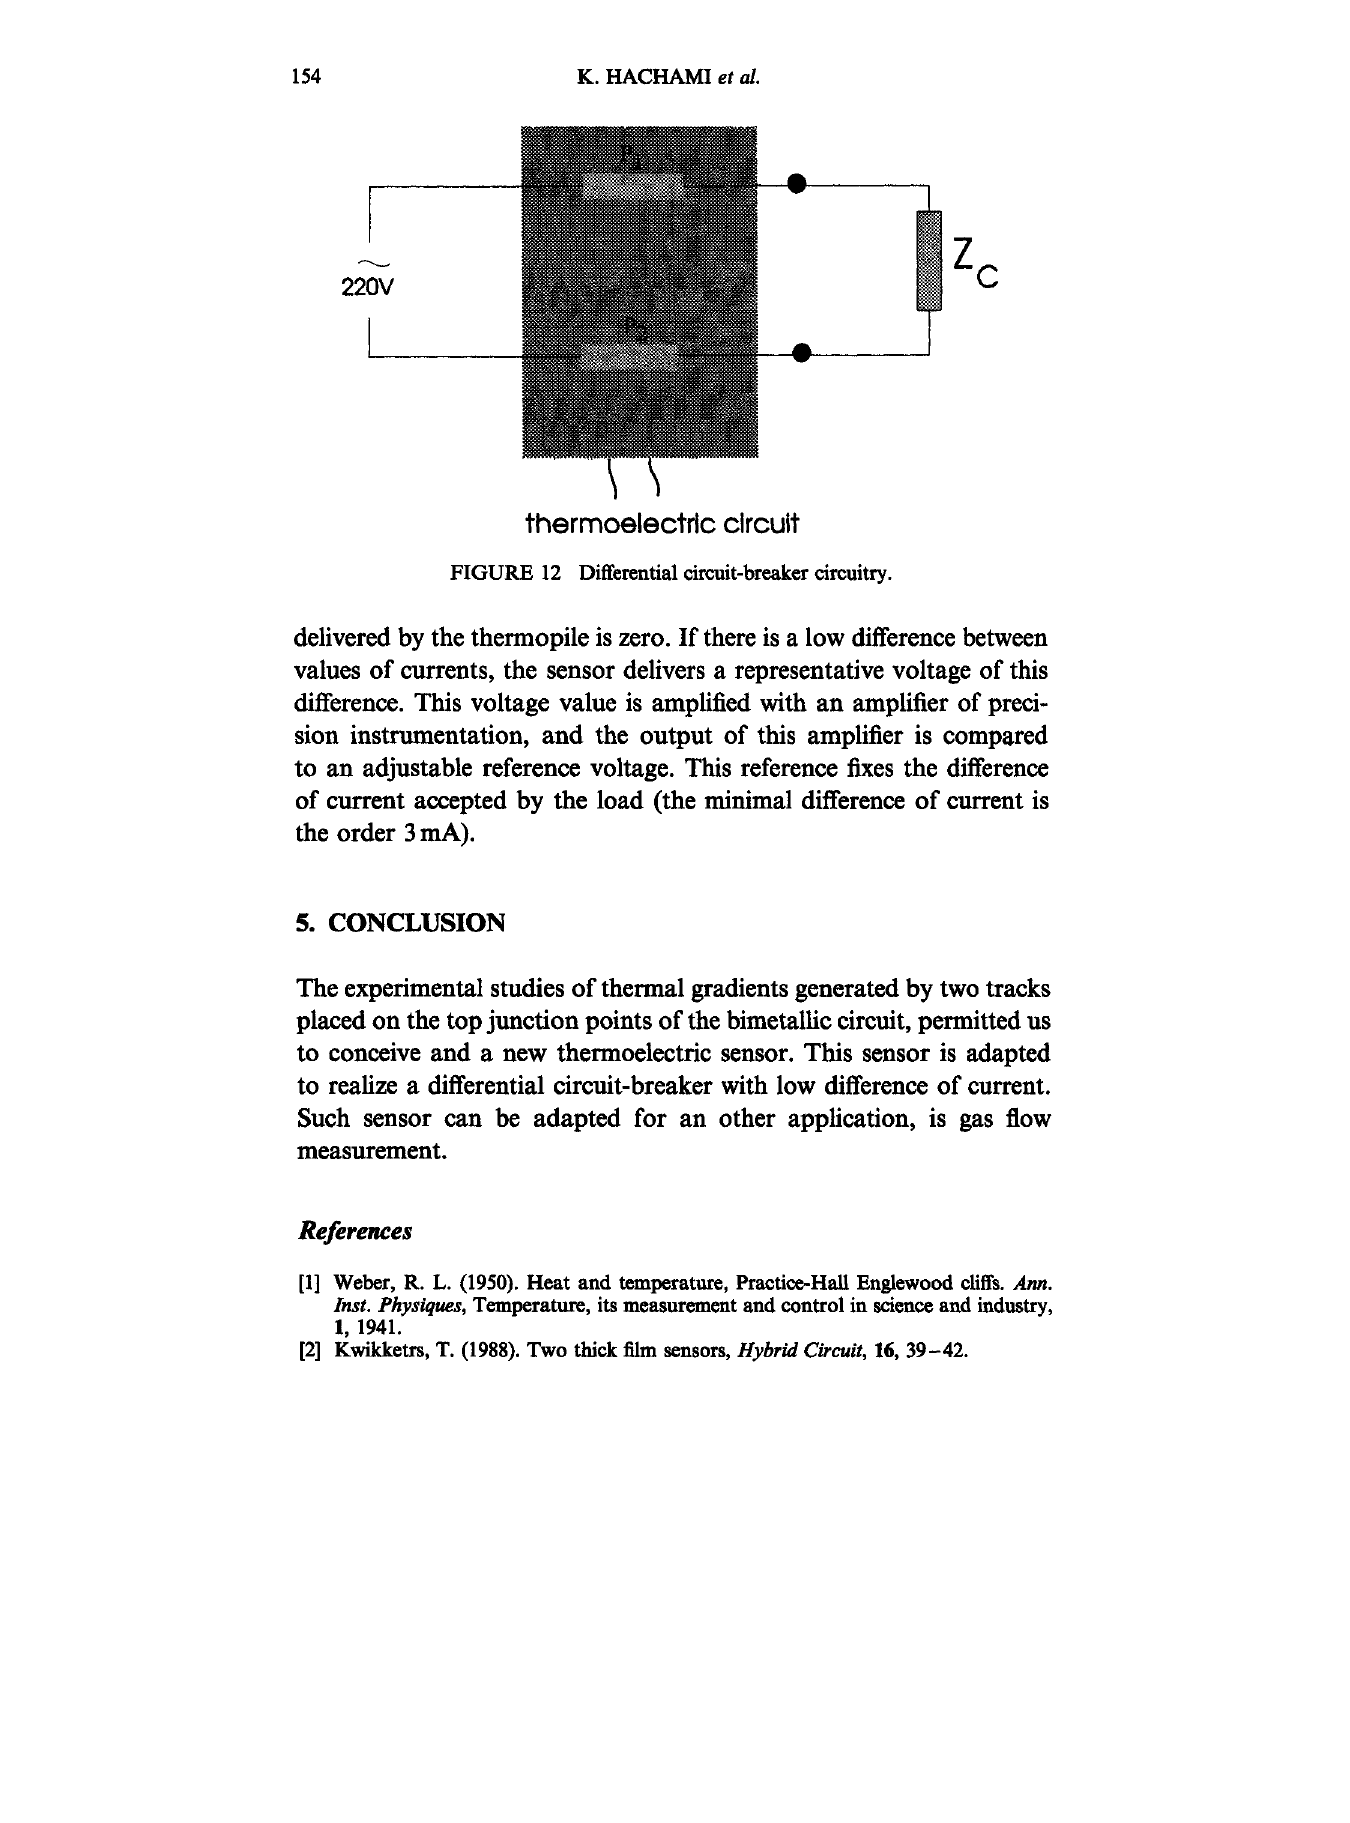
FIGURE 12 Differential circuit-breaker